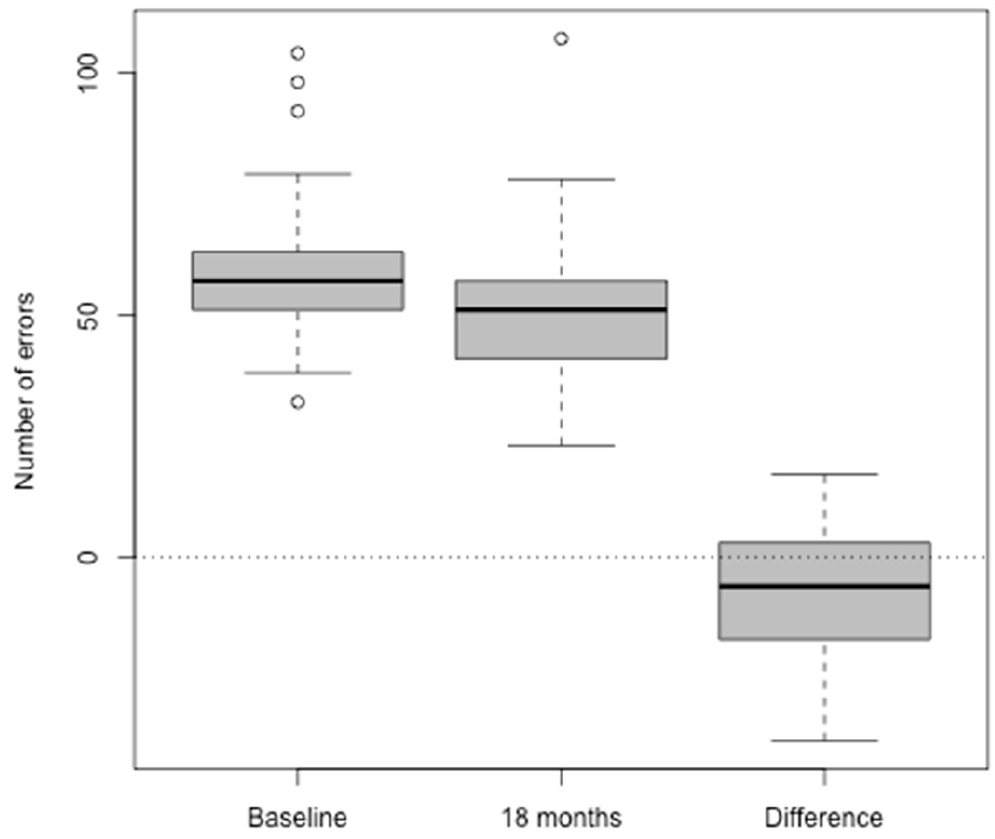
Figure 1. Executive function (GML) raw scores at baseline and 18 month assessments and their pairwise di ff erences. The Y axis shows the number of errors in responses. The X axis shows assessment points and the di ff erence in scores between the baseline and 18 month post-hearing aid fitting assessments. The boxes represent the observations between the first and third quartile. The hollow circles represent outliers. The bolded lines in the boxes represent the medians.